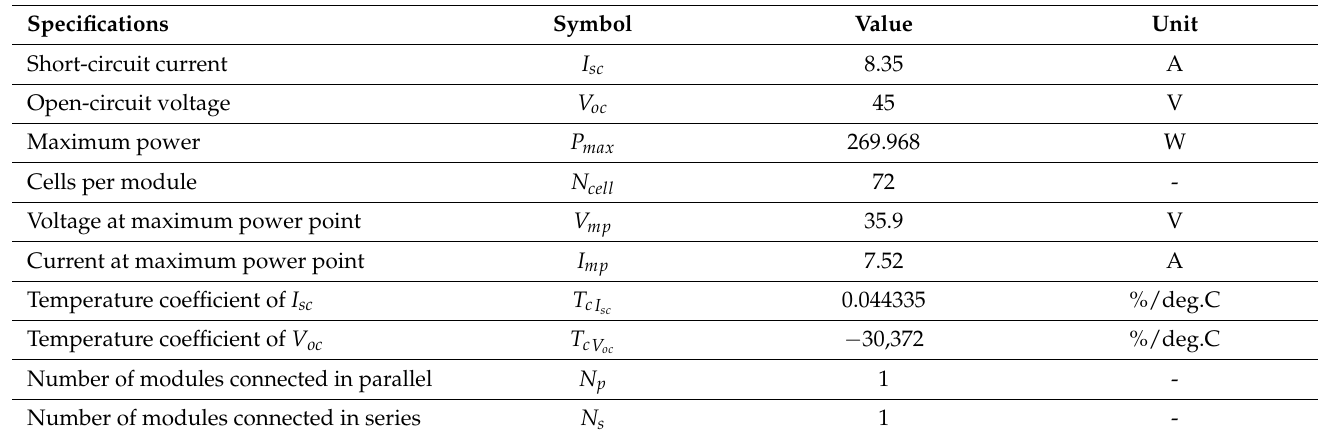
Table 5. Characteristics of the PV module.